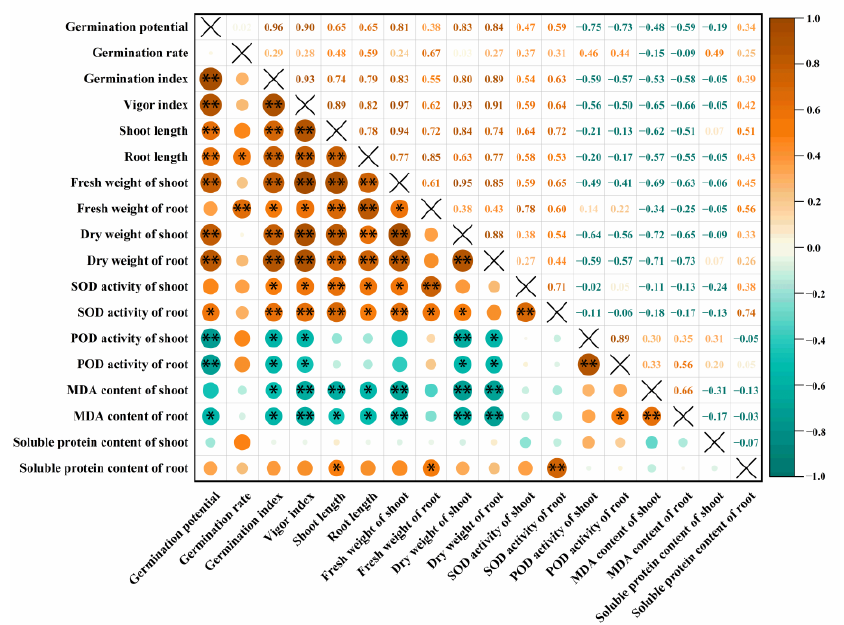
Figure 7. Correlation analysis of melatonin and flooding stress. **: significant at the 0.01 probability level ( p < 0.01); *: significant at the 0.05 probability level ( p < 0.05).